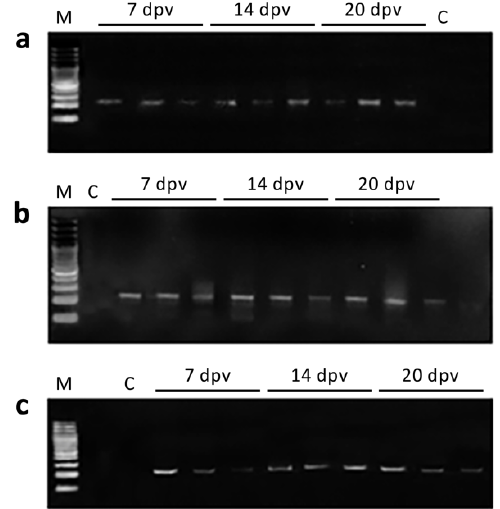
Figure 1. Detection of pcDNA-MCP in vaccinated gilthead seabream at 7, 14, and 20 days post- vaccination (dpv) in different tissues: ( a ) muscle at the site of injection; ( b ) caudal fin; ( c ) head kidney; M, molecular weight marker (100 bp DNA ladder); C, negative control (fish injected with the empty plasmid).